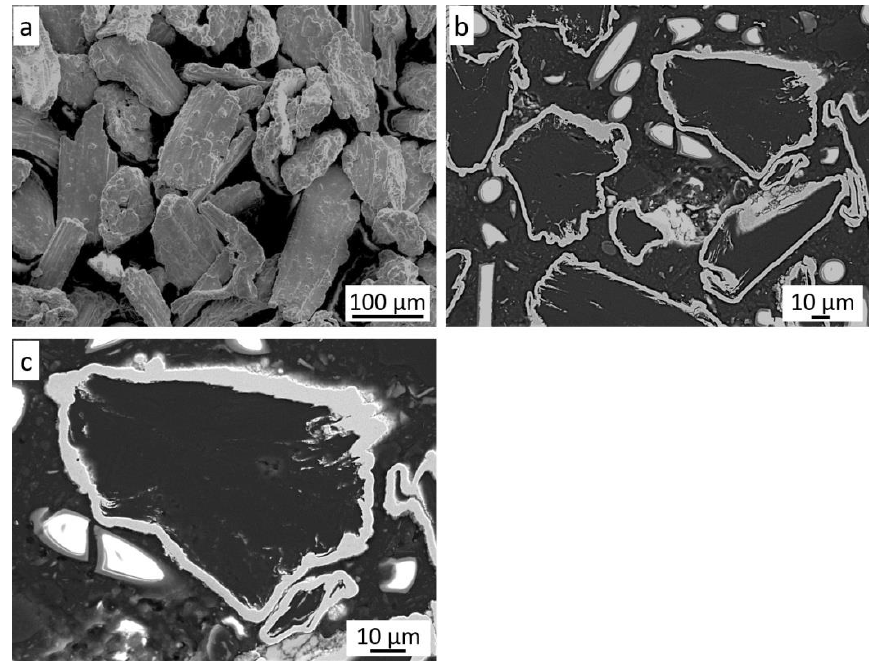
Figure 3. The Ni-25Graphite powder: ( a ) morphology, ( b ) cross-section, ( c ) nickel shell. The particle size distribution measurement revealed significant grain size differences for both powders. The parameters of the Ni-25Graphite powder are d10 = 47.2, d50 = 80.8, d90 = 138.9 µ m (Figure 2a), and for Diamalloy 3004 are d10 = 7.5, d50 = 19.9, d90 = 45.6 µ